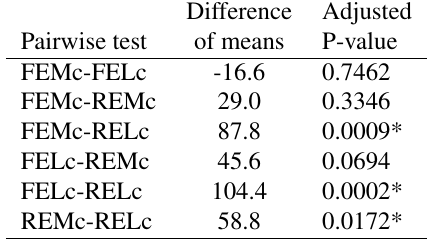
Table 11. Tukey Test Results for DAP-TC (threshold is